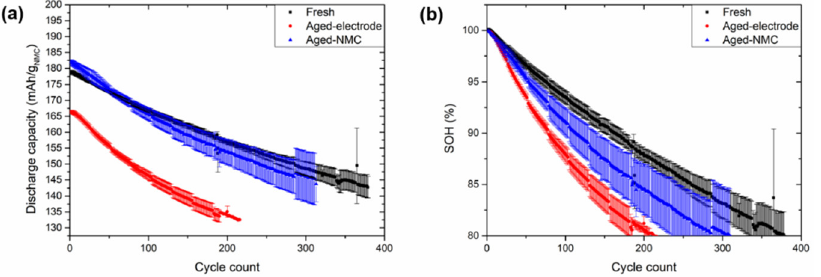
Figure 1. Galvanostatic cycling experiments conducted at C/3 current rate: ( a ) discharge capacity per gram of NMC and ( b ) capacity retention during the cycle life of the cells. per gram of NMC and ( b ) capacity retention during the cycle life of the